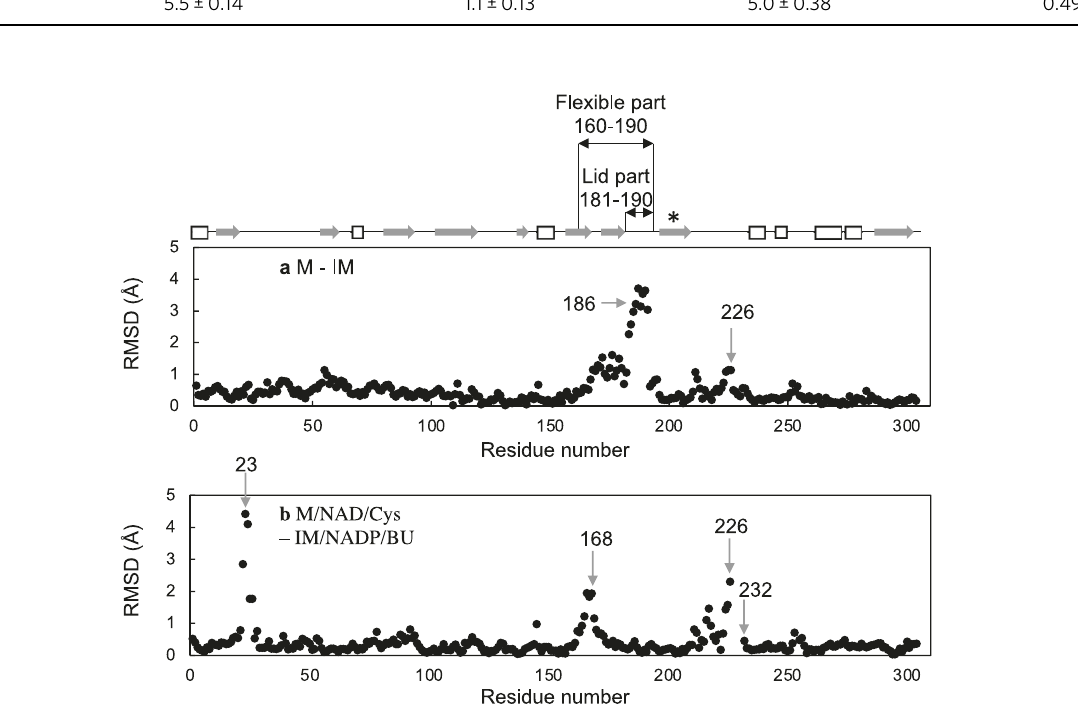
Fig. 4 Conformational change induced by heat-treatment. Differences between the backbone atoms of the M and IM ( a ) and M/NAD/Cys and IM/ NADP/BU ( b ) structures are superimposed. The arrows and numbers indicate the residues mentioned in the text. The fl exible (160 – 190 aa) and lid part (181 – 190 aa) are highlighted by two-way arrow. The helix structure (194 – 210 aa) described in Fig. 6 is marked with an asterisk.